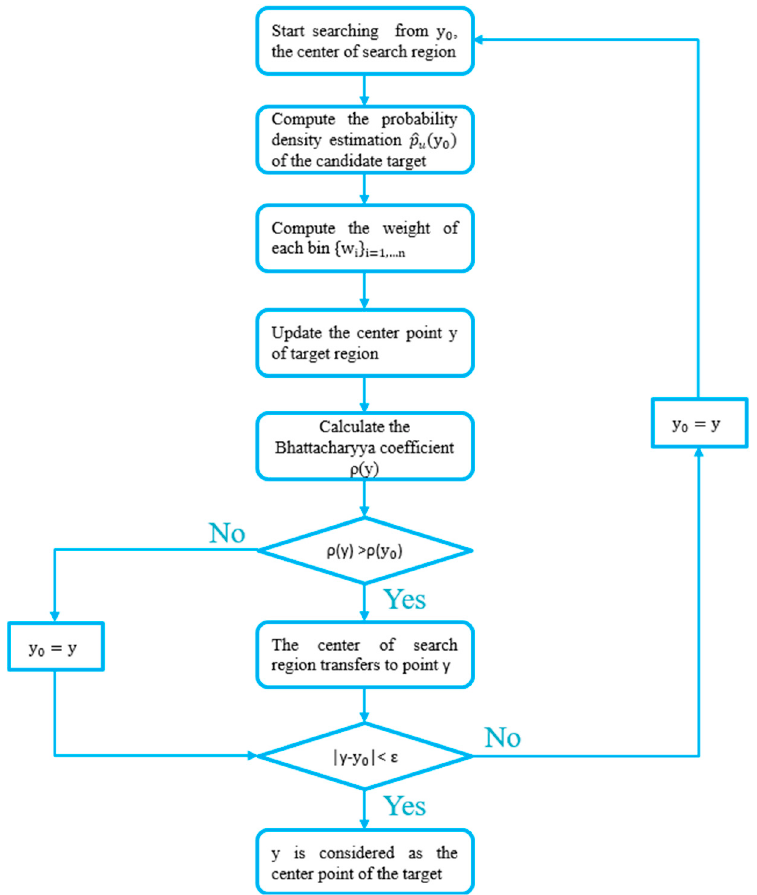
Figure 6. The process of the mean shift algorithm.